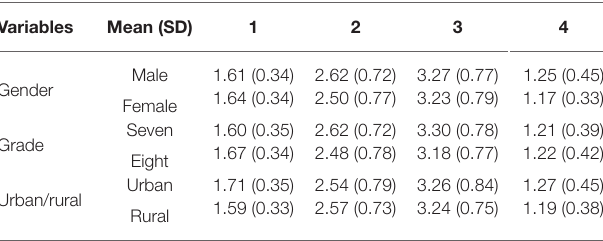
TABLE 1 | Means and standard deviations for the variables ( N = 1,009).